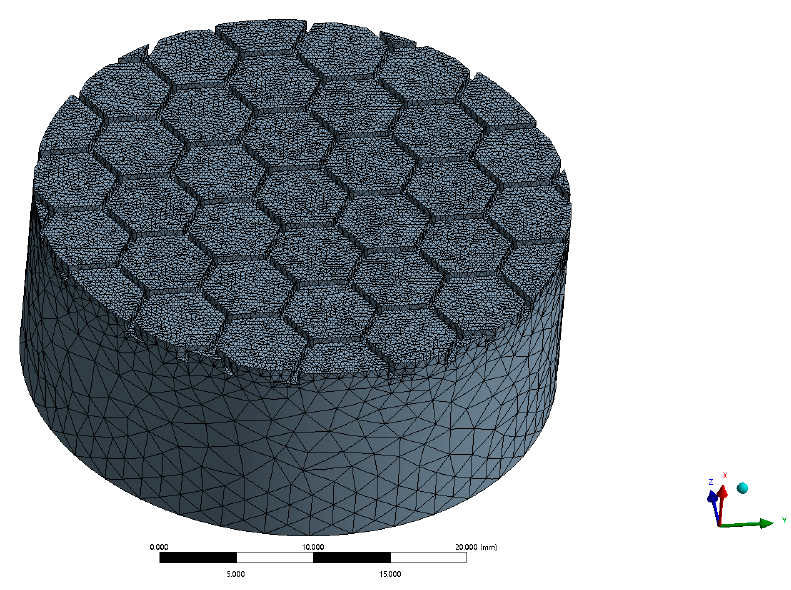
Figure 8. The simulation units of four cross-grooved texture: (T) triangle-textured; (S) square-textured; (H) hexagon-textured; (R) round-textured.